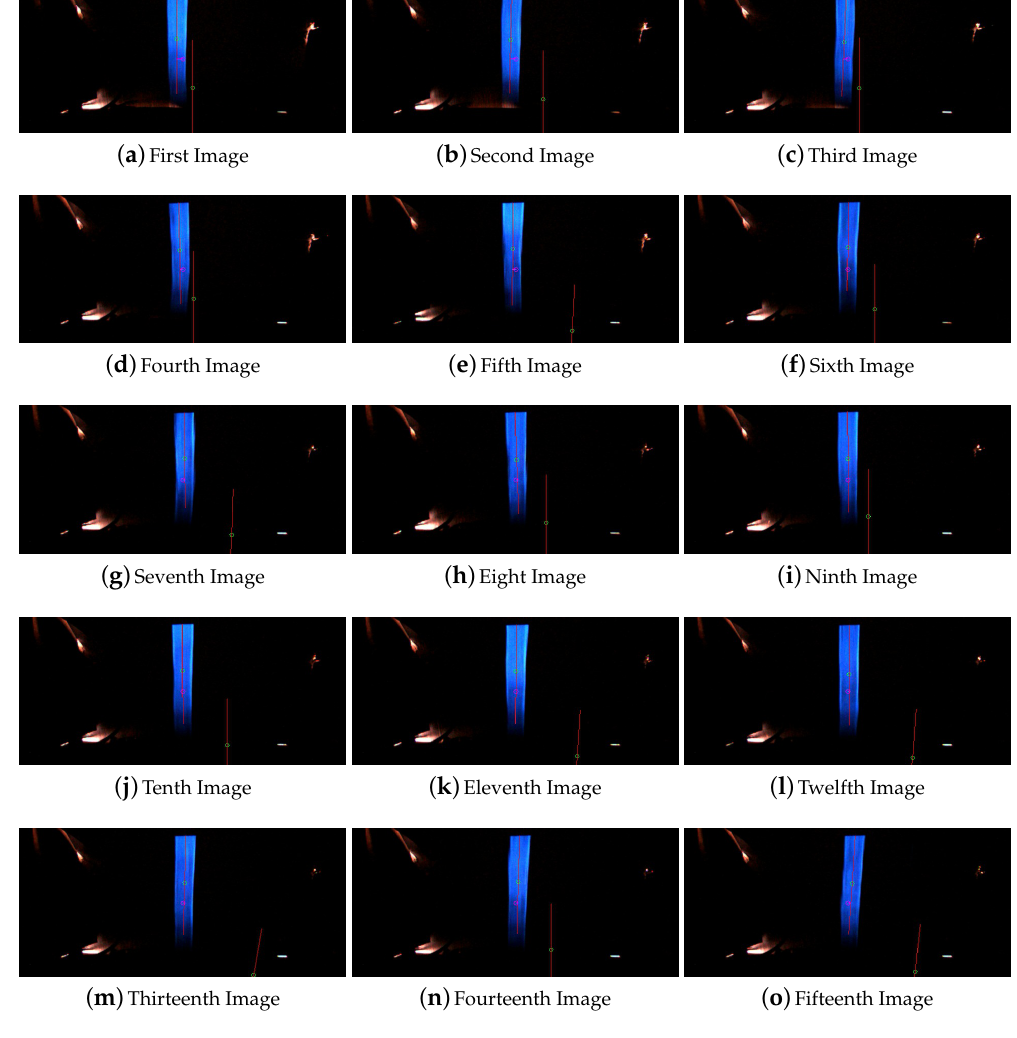
Figure 16. Sequence of images captured with a rejected false positive